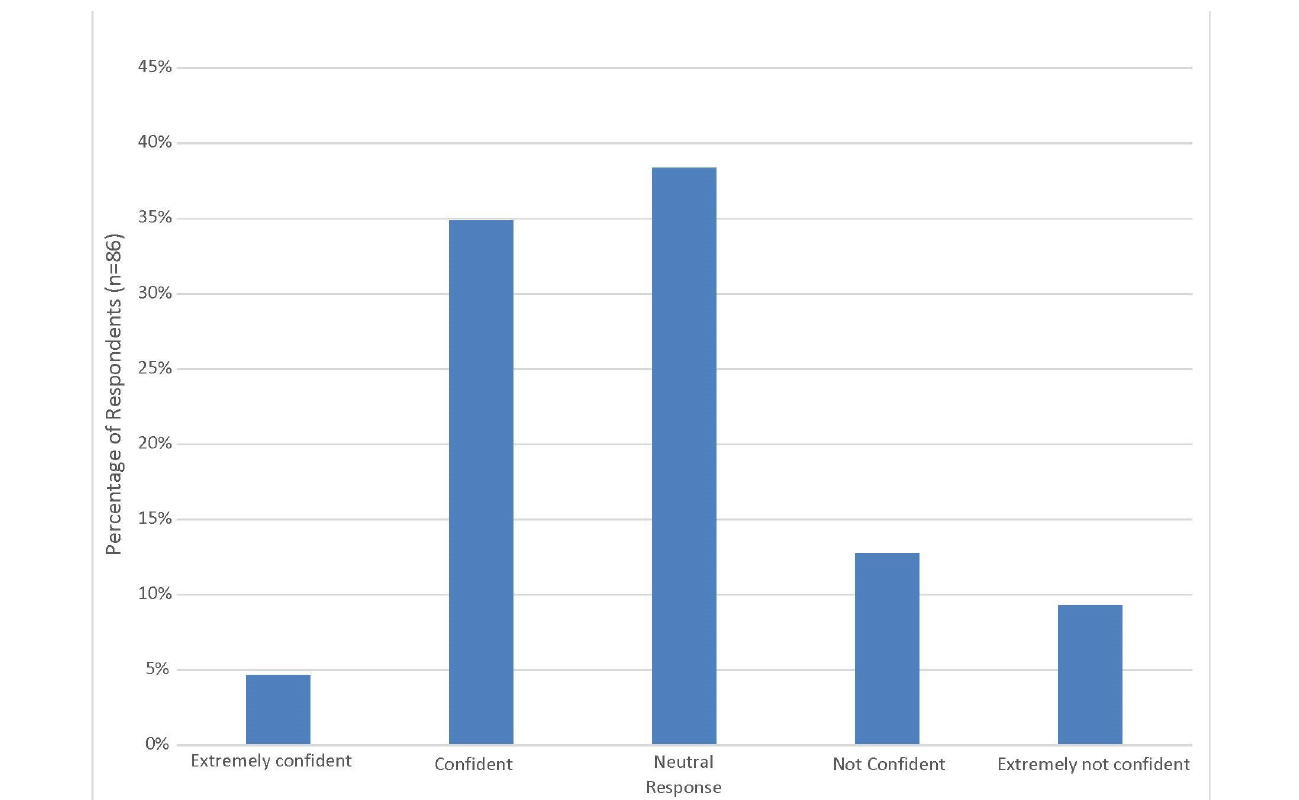
Figure 1. How confident do you feel that you could correctly perform a prehospital cricothyrotomy on the first attempt tomorrow?